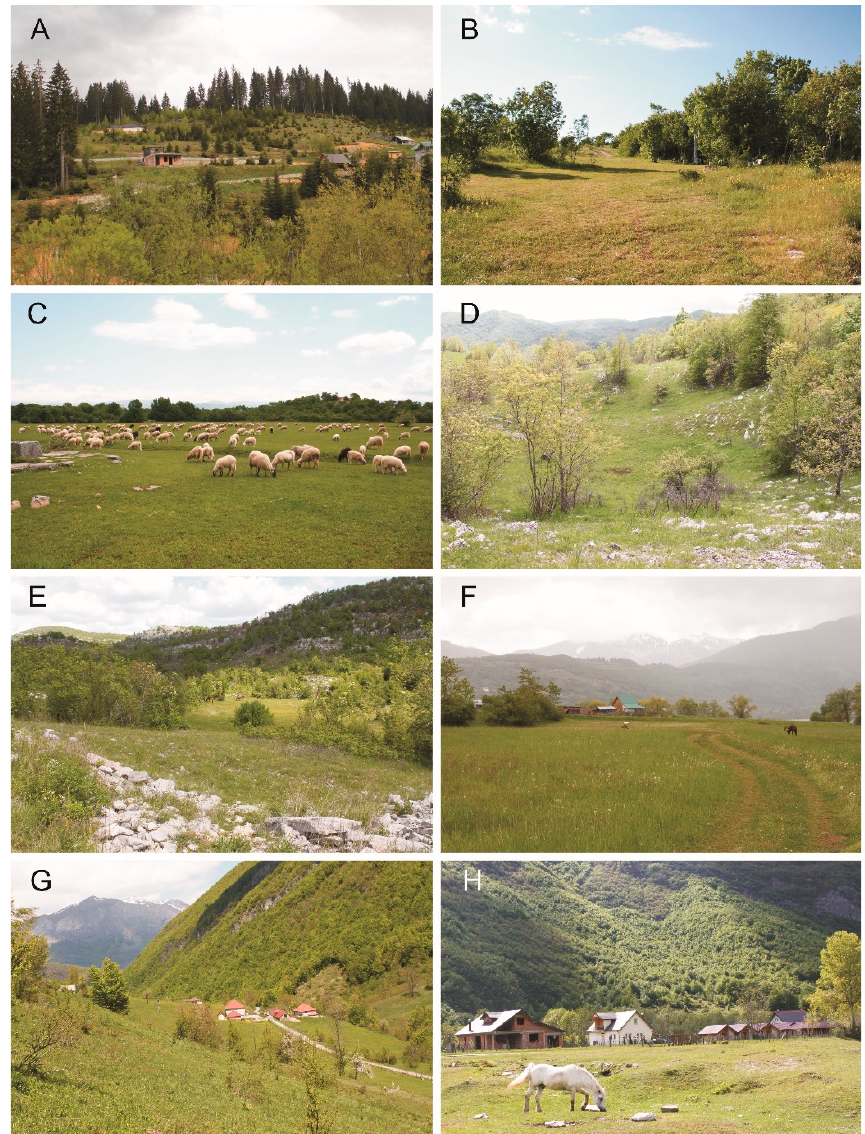
Figure 3. Collection localities of the scarabaeoid beetles in Montenegro (2019, 2021): ( A )—Dra č enovac at Rožaje, ( B )—Crnodoli at Nikši ć , ( C )—Ri đ ani at Nikši ć , ( D )—Bro ć anac Nikši ć ki at Nikši ć , ( E )— Č evo at Cetynia, ( F )—Plav, ( G )—Škala at Gusinje, ( H )—Vusanje at Gusinje (Photos: ( A , D – H )—Sebastian Tylkowski and ( B , C )—Tomasz Gazurek).